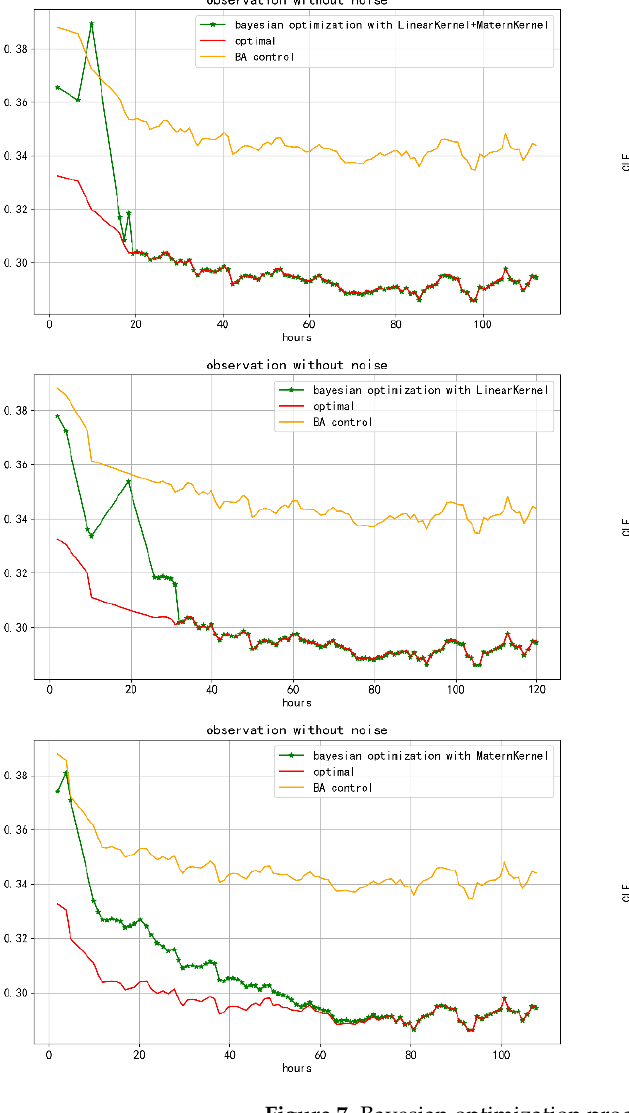
Figure 7. Bayesian optimization process for power-on chiller 2.